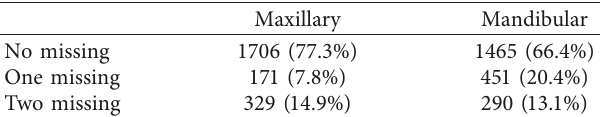
Table 2: Frequency of first molar missing according to